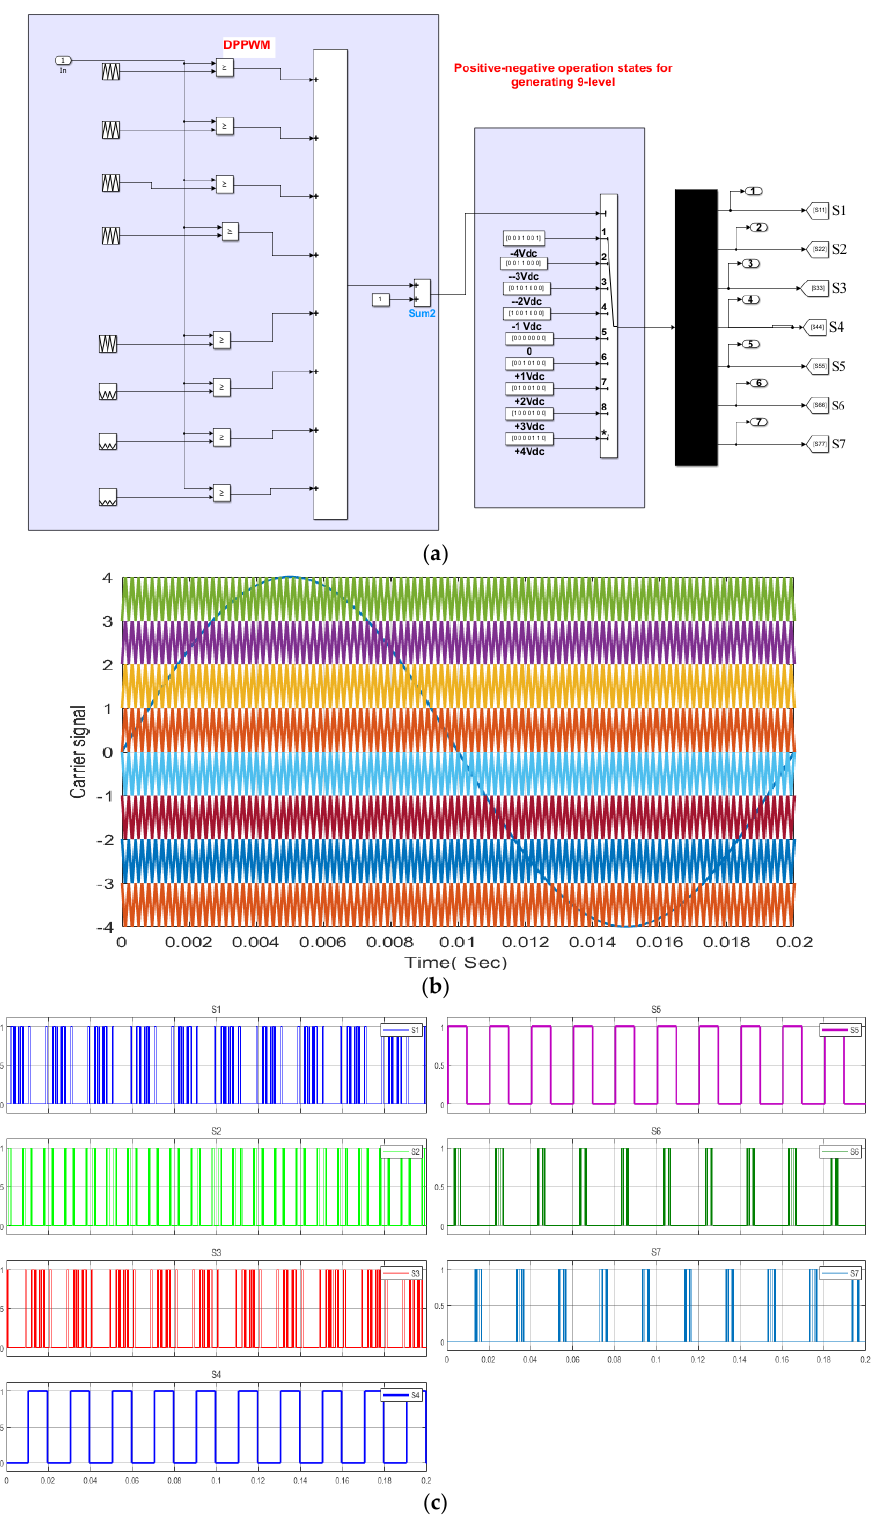
Figure 23. Phase-disposition PWM for seven switches with nine levels. ( a ) Simulation diagram of DPPWM, ( b ) carrier signals with the reference signal, and ( c ) pulse signals for seven-switch (S1 to S7) of the proposed nine-level